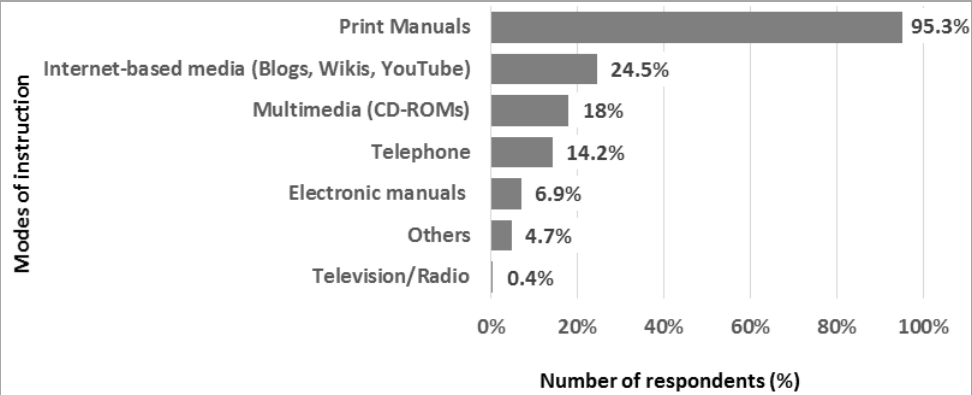
Figure 2. Modes of